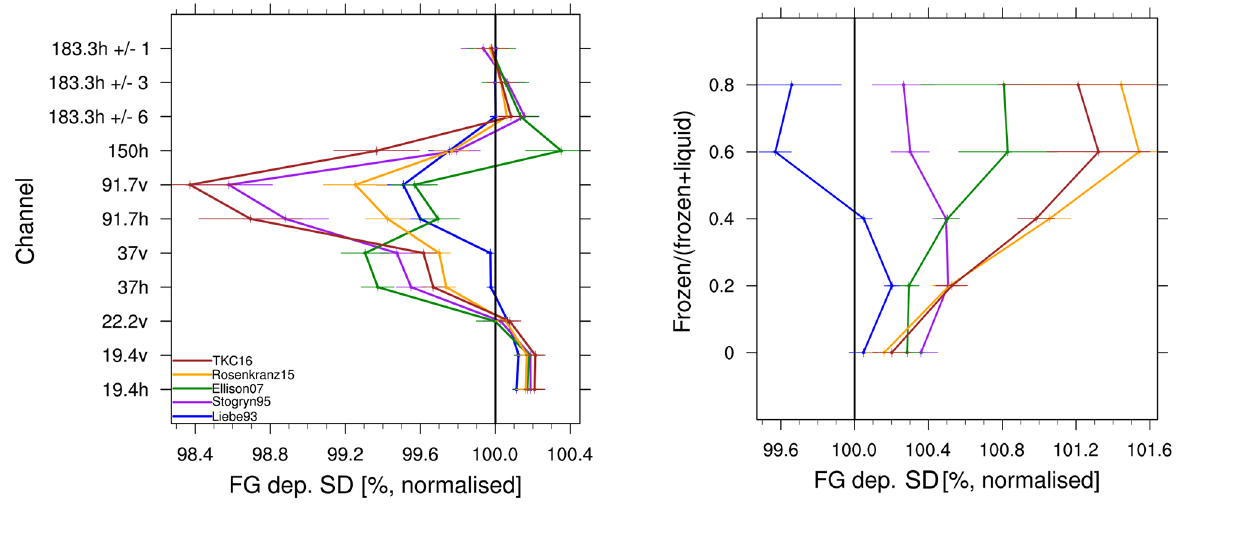
Figure 11. Standard deviation in FG departure from SSMIS-F17 normalised by Liebe89 for (a) different channels for samples with no frozen hydrometeors containing some cloud (about 16.8% of the full sample size from the Southern Hemisphere) and for (b) different ratios of the frozen hydrometeor amount versus total hydrometeor amount at 183 ± 6h. The horizontal bars indicate a 95% confidence range. Results cover all active and passive data (including areas of cold-air outbreaks) in the Southern Hemisphere (20–90 ◦ S) from 1 to 31 August 2016. Different colours refer to different permittivity models, as shown in the